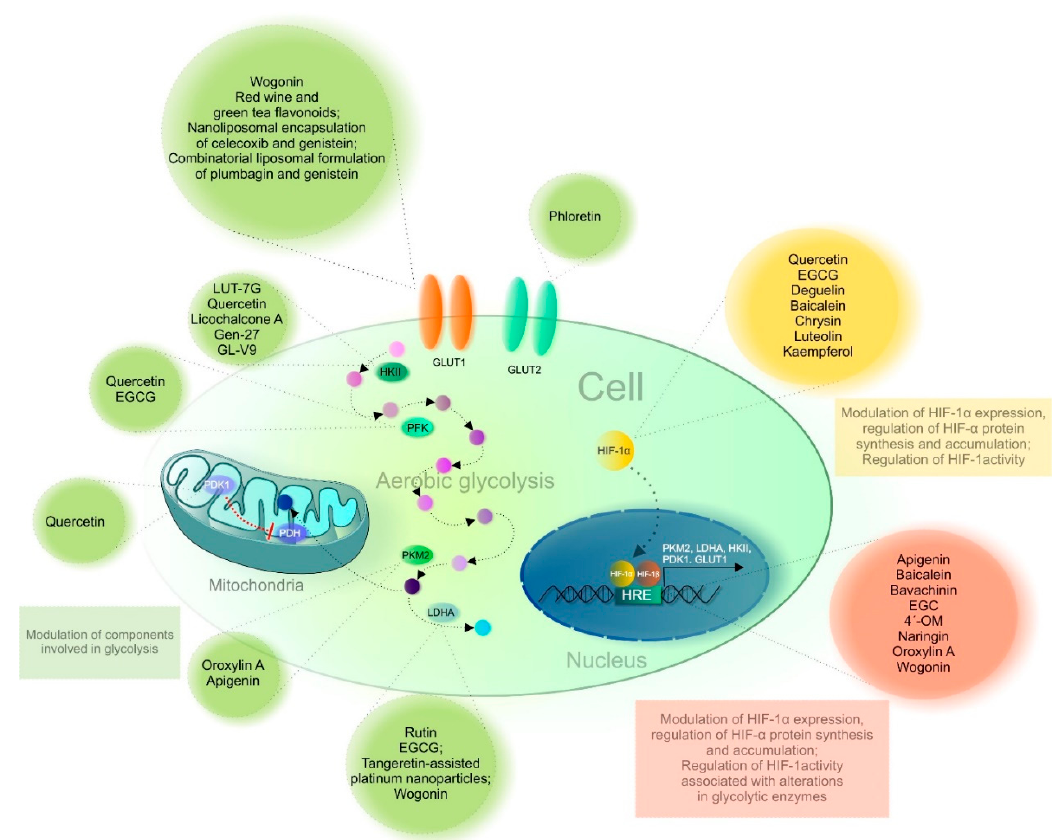
Figure 4. Flavonoids targeting HIF-1 and critical components of glycolysis. Abbreviations: EGCG, epigallocatechin-3-gallate; EGC, epigallocatechin; 4 ′ -OM, 4 ′ -O methylalpinumisoflavone; LUT-7G, Luteolin-7- O - β -D-glucoside; HK 2, hexokinase 2 ; PFK , phosphofructokinase; PKM 2, pyruvate kinase muscle isoform 2 ; LDHA , lactate dehydrogenase A ; PDH, pyruvate dehydrogenase; PDK1, pyruvate dehydrogenase kinase 1; HRE, hypoxia-response elements; HIF-1 α /1 β , hypoxia-inducible factor 1 α /1 β ; GLUT1/2, glucose transporter